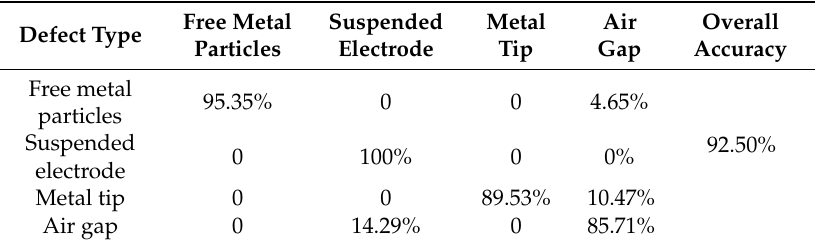
Table 4. Recognition rate of the GGCM method.